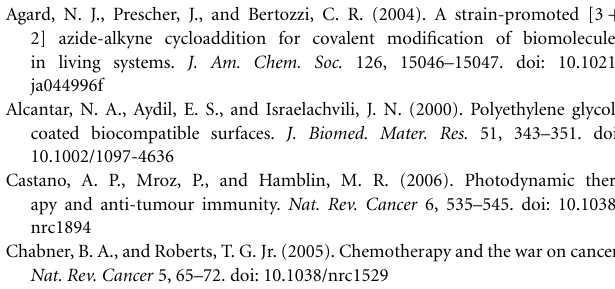
days of treatment using the PrestoBlue™ Reagent (Life Technologies). Treatments: untreated cell control (0.1% v / v DMSO in media, negative control); Pd 0 -resins (0.67mg/mL, negative control); 3–100 μ M of 3a or 6 (negative control); 3–100 μ M of 5FU (positive control); and Pd 0 -resin (0.67mg/mL) + 3a or 6 (BOOM reaction